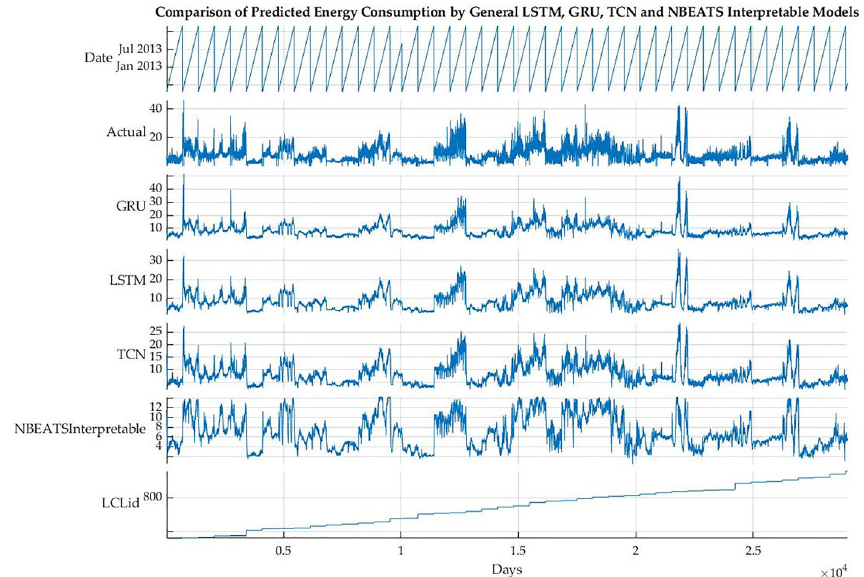
Figure 5. Performance comparison of general models.